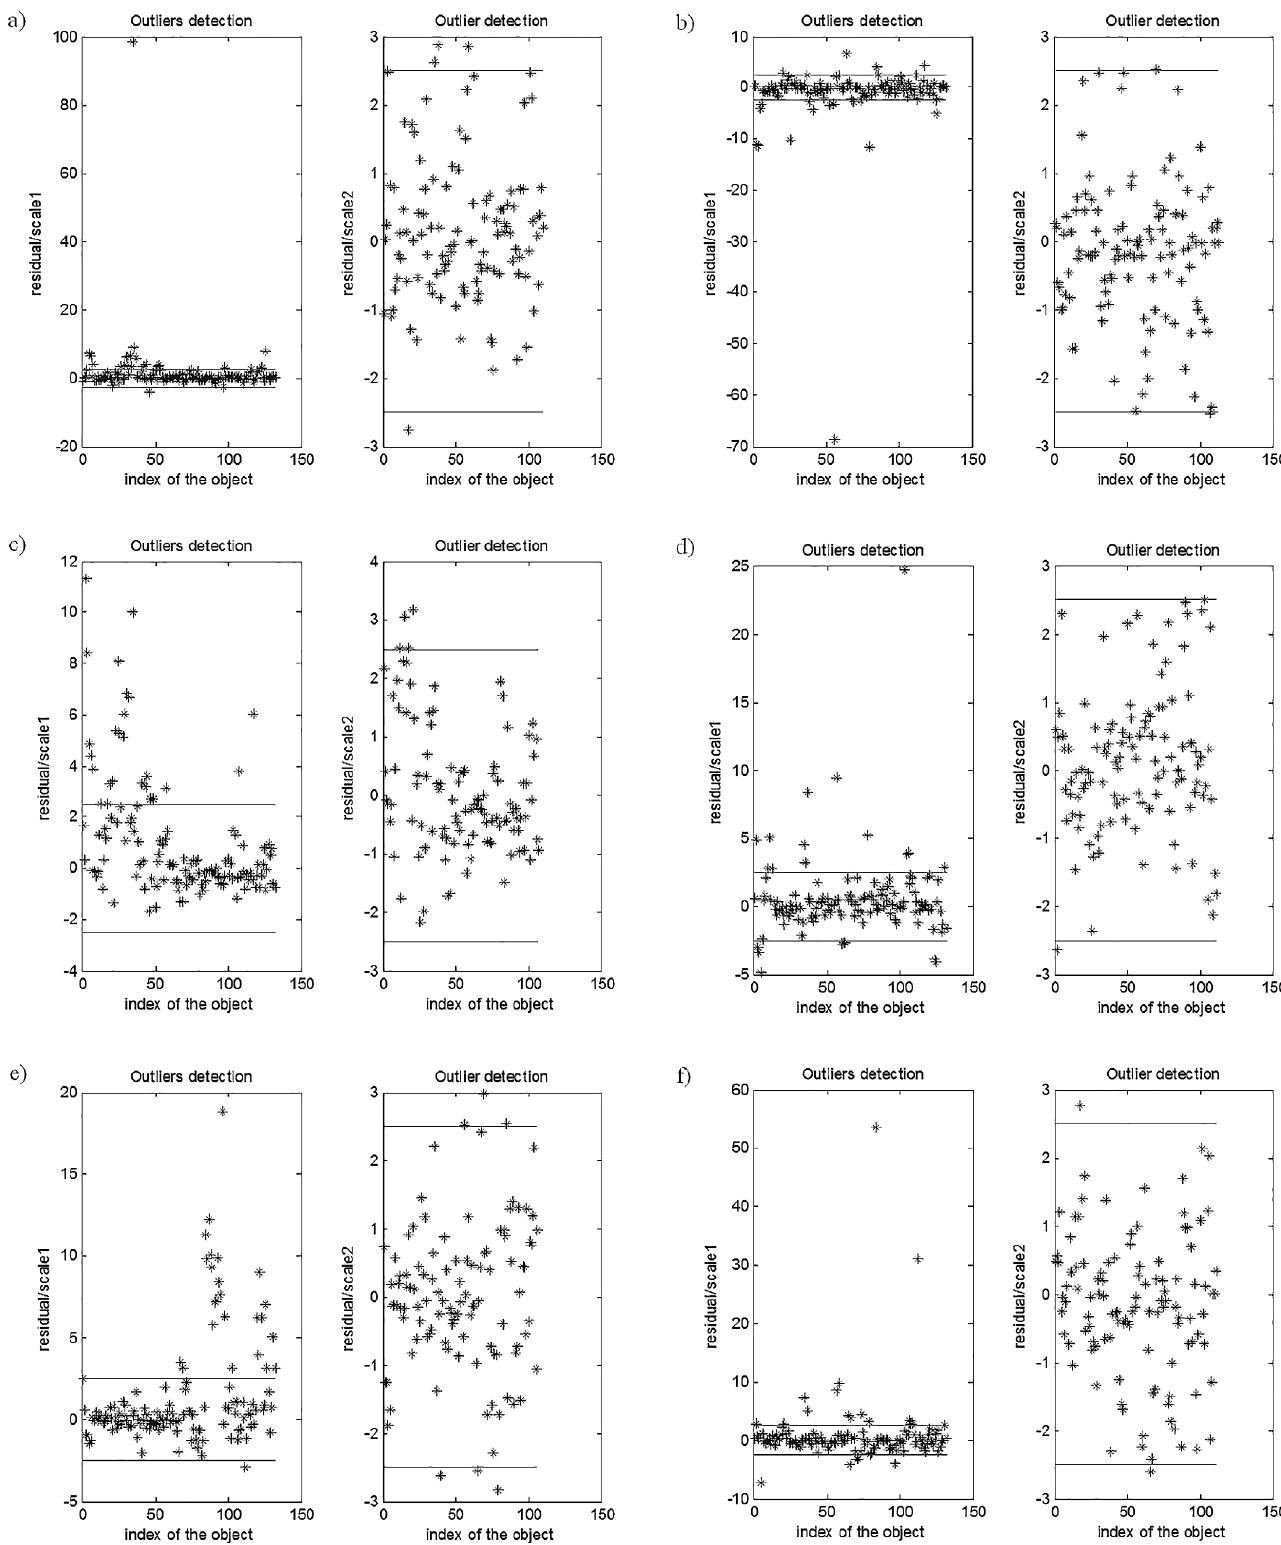
Fig 4. Residuals plots: the first robust scale and the second robust scale for the robust PLS models of trace elements concentrations: (a) As, (b) Ba, (c) Cd, (d) Co, (e) Cr, (f) Cu, (g) Mn, (h) Ni, (i) Pb, (j) Rb, (k) Sr, (l) V and (m) Zn in μ g/g, based on the parameters specified in Table 1, with the assumed fraction of outliers of